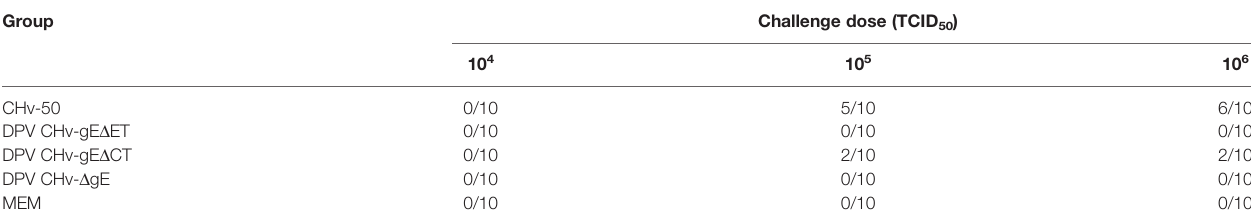
TABLE 3 | Mortality statistics of